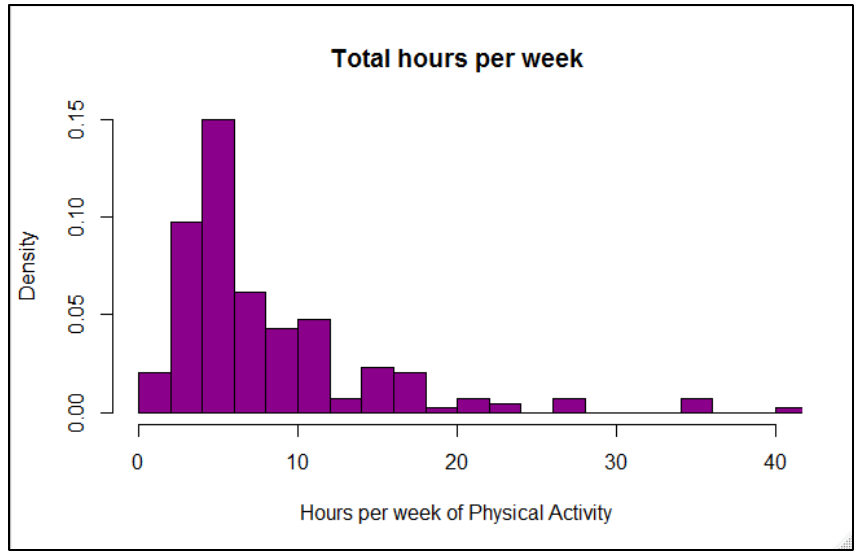
Figure 2. Distribution of participants by total hours per week spent doing all physical activities.